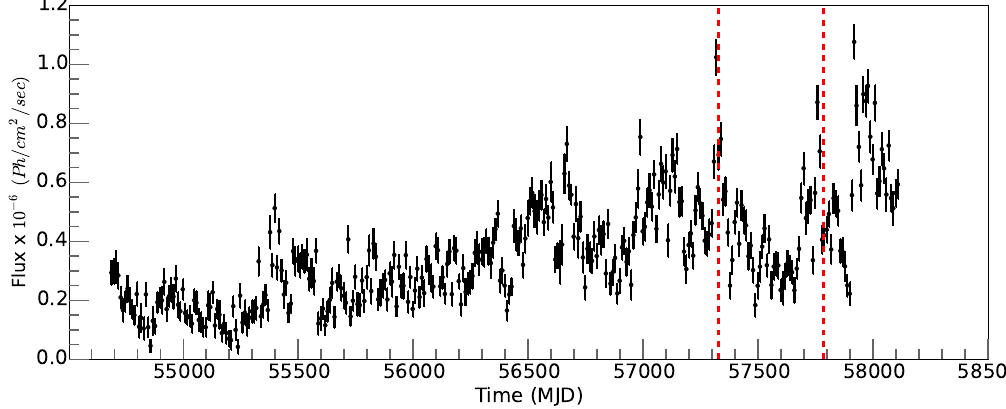
Figure 1. Fermi LAT 10-day binned light curve in the energy range 0.1–300 GeV covering nine years of data (2008 August–2017 August). Epochs for observations carried out with NuSTAR are marked by vertical dashed red lines.These observations are carried out on 3 November 2015, 1 February 2017 and 4 February